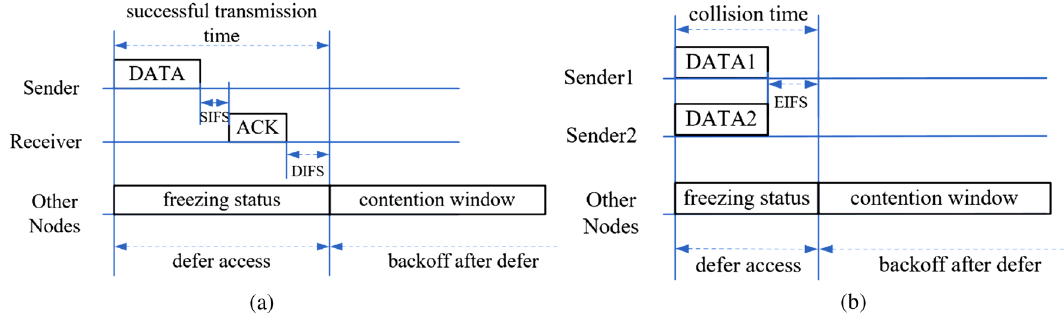
Figure 1. Successful transmission process and collision process based on the DATA/ACK type. The successful transmission time is shown in ( a ) and the collision time is shown in ( b of throughput performance. Although throughput and network delay are two main parameters of DCF mecha- nism, they cannot be directly used to evaluate performance of WBN. In fact, there are two problems that need